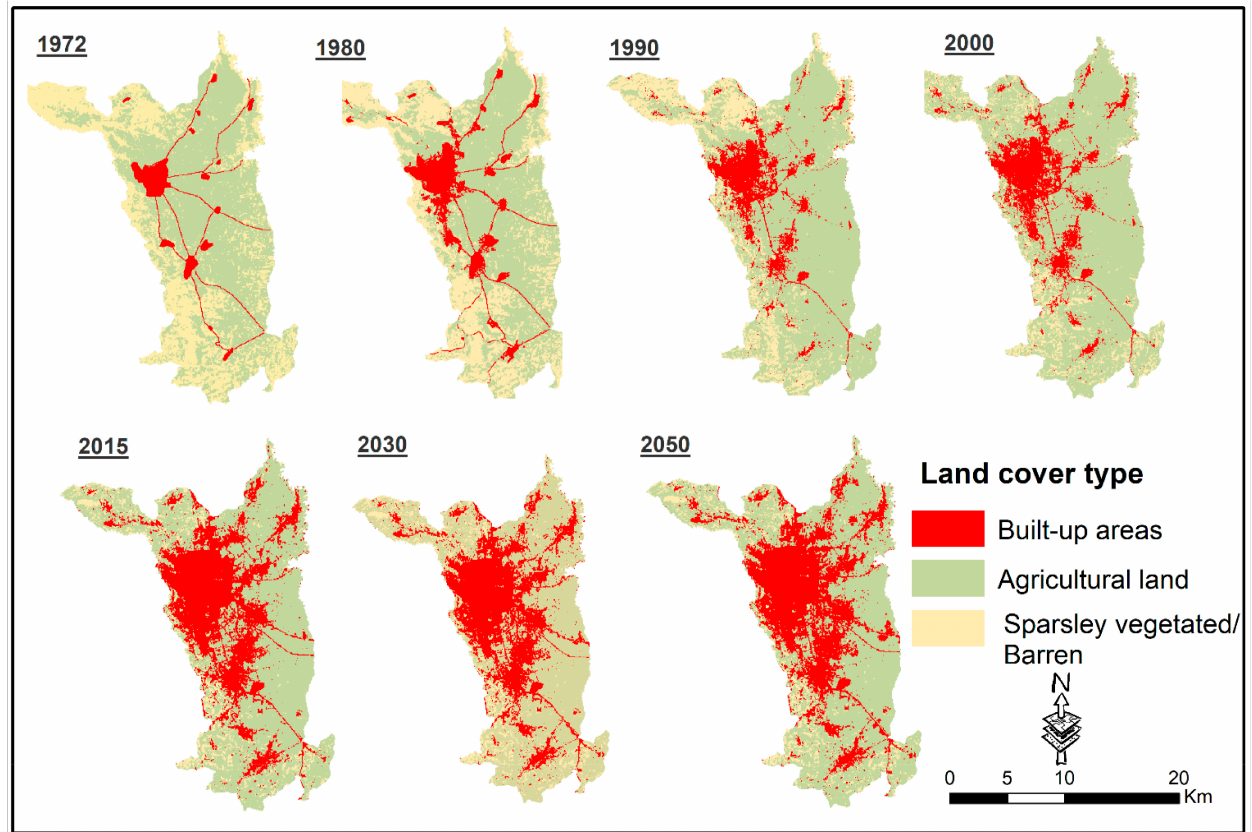
Figure 5. Long-term land cover timeline for the Greater Irbid Municipality (1972–2050). Overall, built-up areas extent increased across the 78 years, with a total increase of 77.8 km 2 or 72.7%. (Table 5). According to the results during the mapping period, the total built-up areas coverage was 29.2 km 2 (9% of relative coverage) in 1972 and 100 km 2 (31% of relative coverage) in 2015, and will likely increase to 107 km 2 (33% of relative coverage) by 2050. Although persistently increasing, built-up areas change across the 78 years was not uniform in either space or time. Spatially, the southern and eastern parts of GIM area exhibited urban growth faster than the northern or western parts. Temporally, the rate of increase showed a decline across the study period, with the third and fourth intervals of 1990–2000 and 2000–2015 having the highest rate of built-up areas expansion at 68.6 and 41.4%, respectively. However, the rate of increase will likely decline by 2050 at 6.6% reflecting the impacts of the economic and housing market